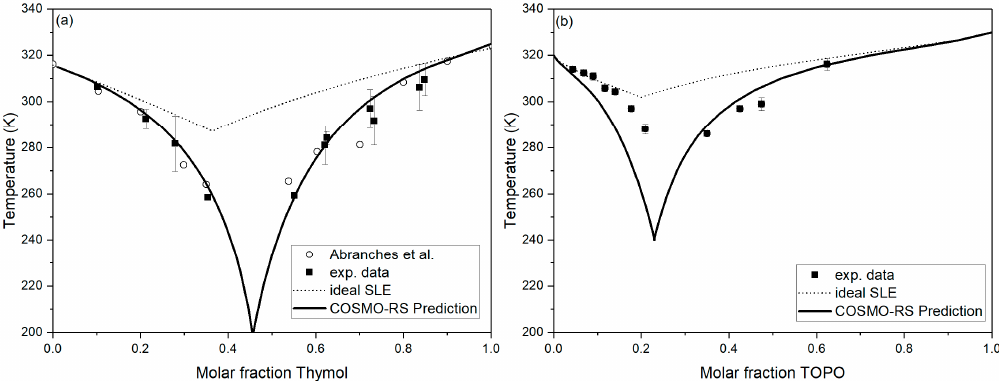
Figure 1. Experimentally determined solid–liquid equilibrium (SLE) of ( a ) L-menthol and thymol and ( b ) L-menthol and TOPO following the cloud point method. The obtained values of the L-menthol and thymol are additionally compared with those reported by Abranches et al. [48]. Additionally, the ideal SLE curve and the prediction from COSMO-RS are shown.